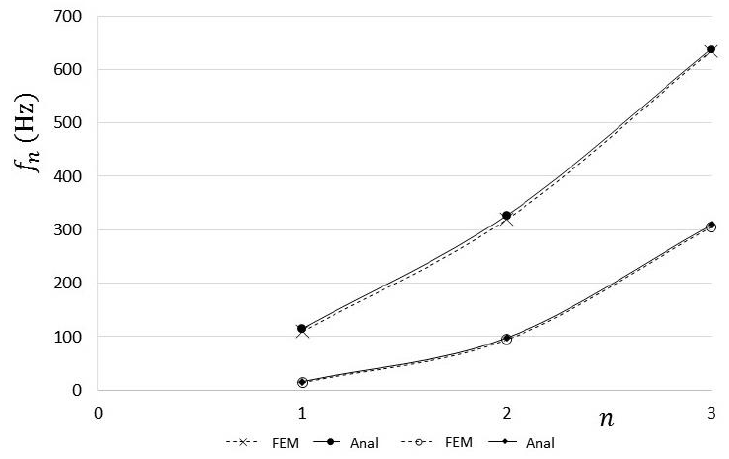
Figure 6. Comparisons between the analytical calculations and those obtained using a finite-element method.